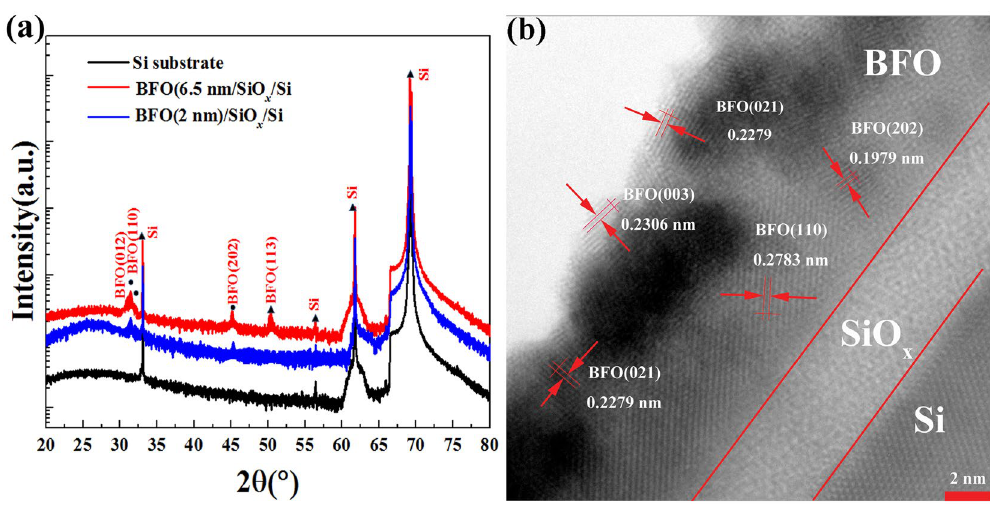
Figure 2. ( a ) XRD patterns of BFO/SiO x /Si heterostructures and Si substrate at various 2 θ . ( b ) TEM results of 6.5 nm thick BFO